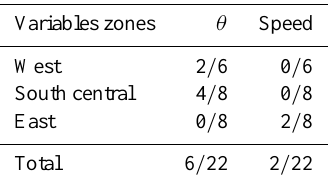
Table 6. Summary of the statistical indexes. Cases where the HR run is worse than the CTL run, with respect to the total number of